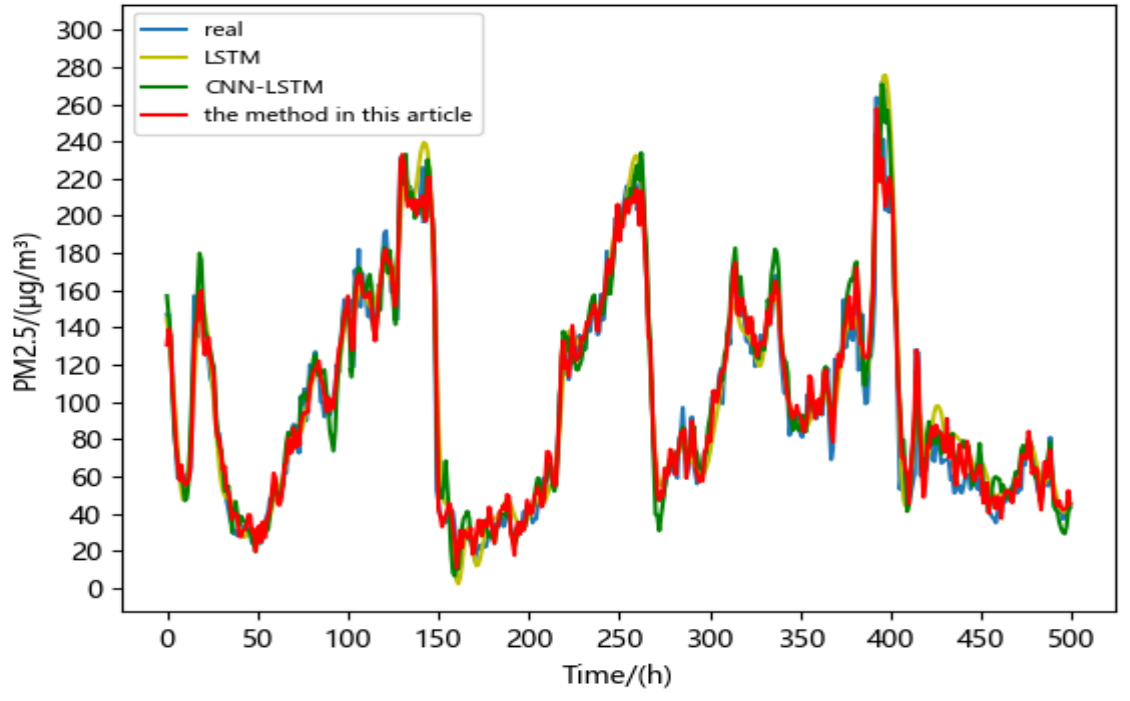
Figure 5. The prediction results of the three methods with a prediction step of 1 h.